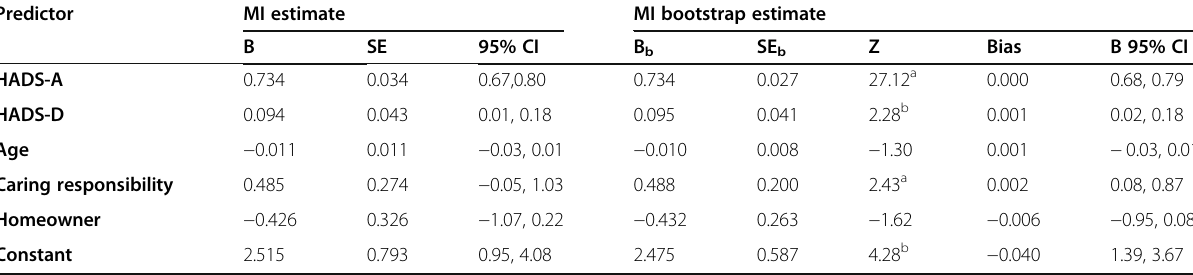
Table 2 Prediction model estimates and bootstrap estimates Predictor MI estimate MI bootstrap